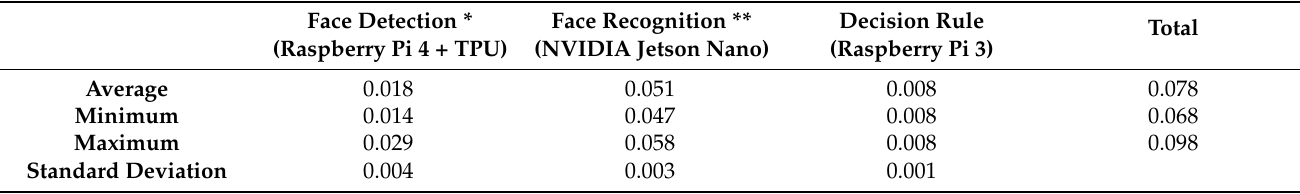
Table 1. Operators’ processing time in